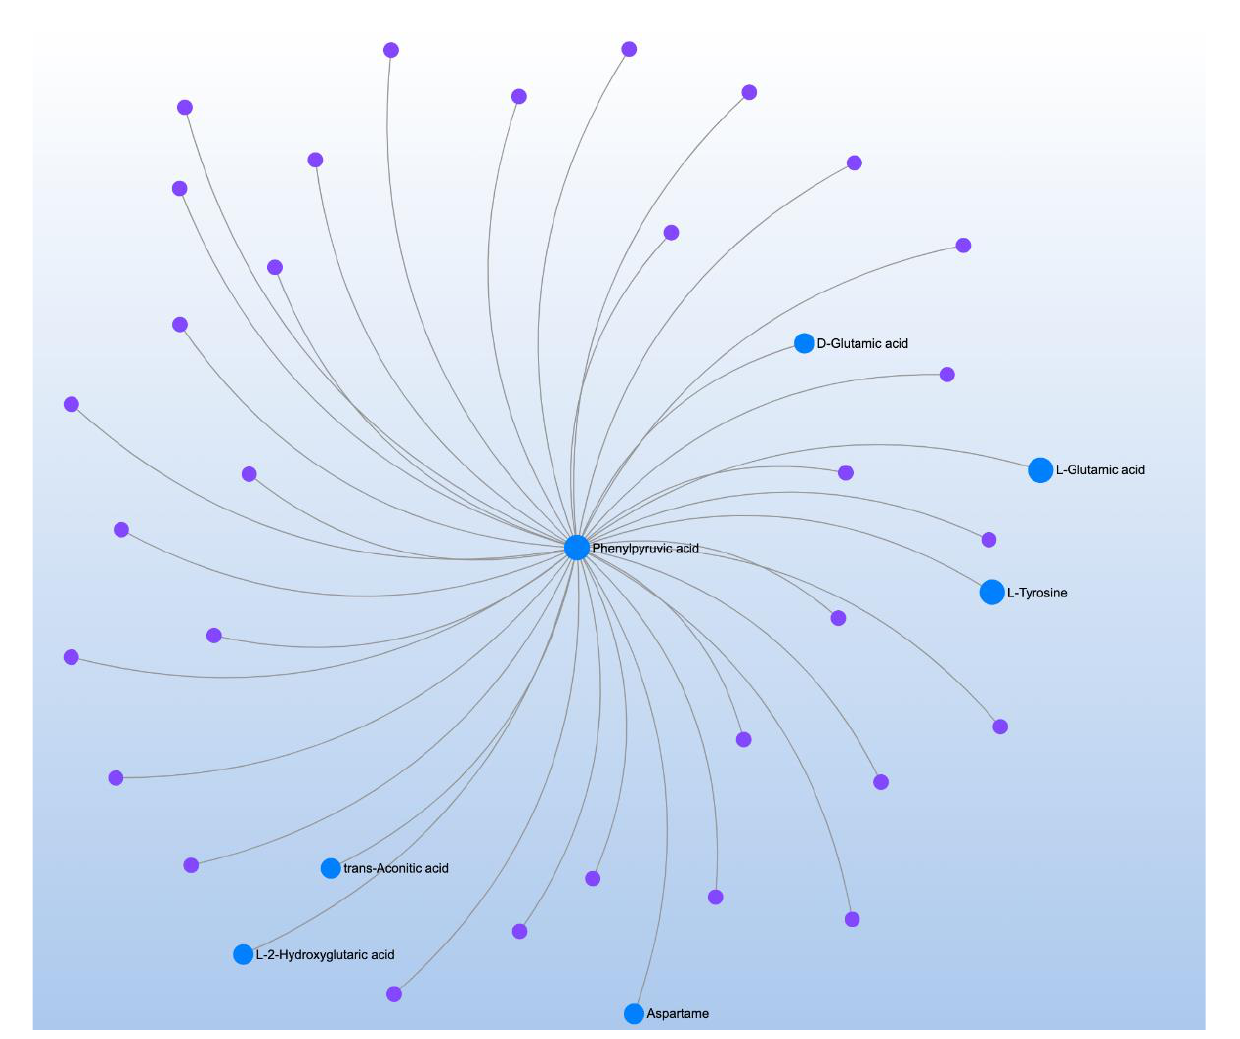
Table 13. Metabolites and their pathways which correlate with the intracellular glutathione redox ratio.